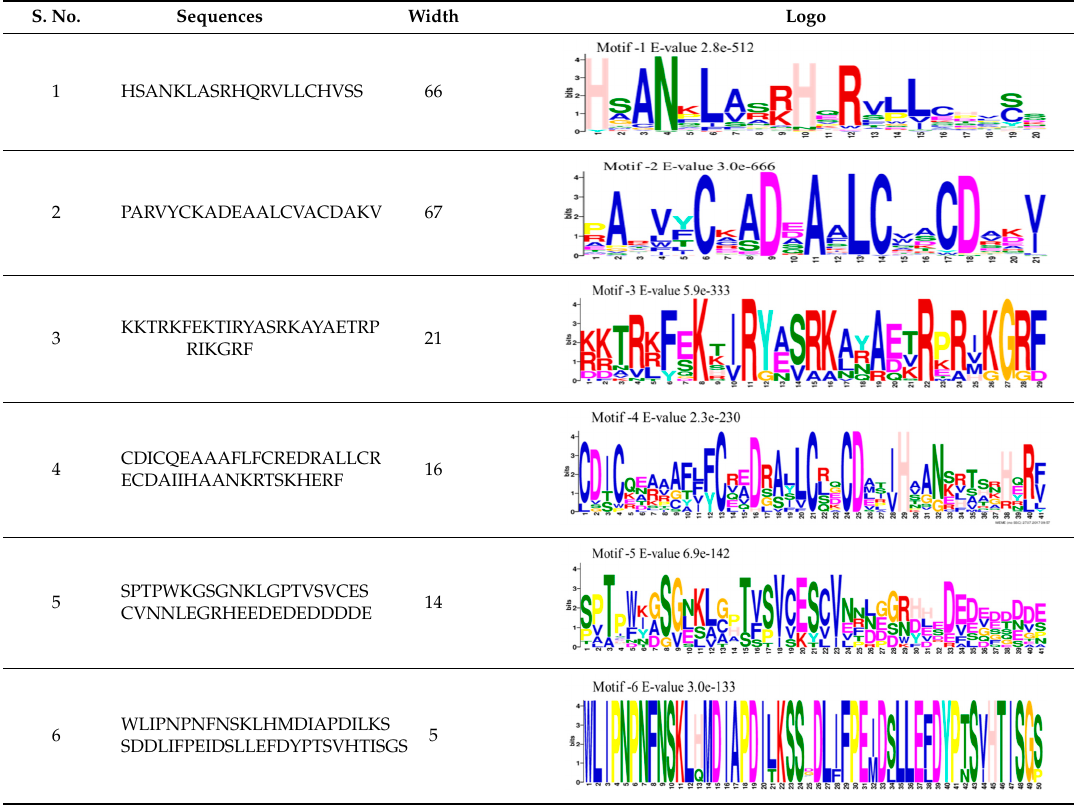
Table 1. The sequence analysis and weblog of 10 identified motifs of the BBX gene family in seven Rosaceae species.